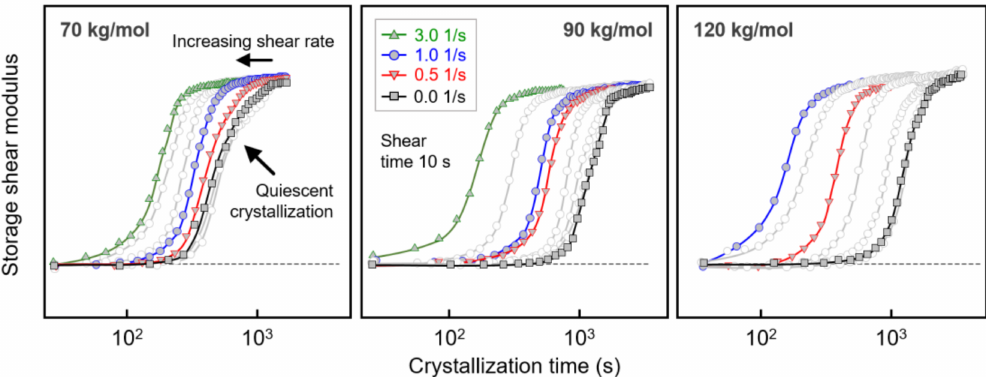
Figure 3. Storage shear modulus of PLLA with molar masses of 70 ( left ), 90 ( center ), and 120 kg/mol ( right ) as a function of crystallization time, after shearing the melt at different rates at 135 ◦ C for 10 s. Note that for PLLA with a molar mass of 120 kg/mol, shearing the melt at 3 1/s led to crystallization during the 10-s-shear step, with the data therefore